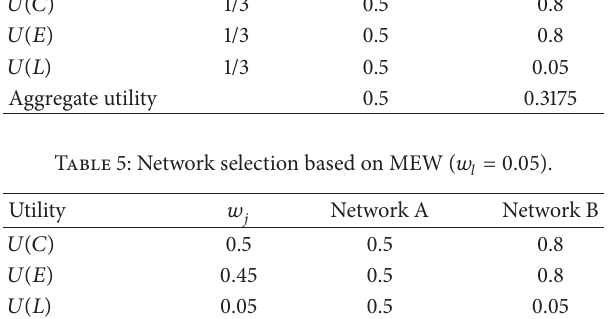
Figure 1: Performance comparison of load with different